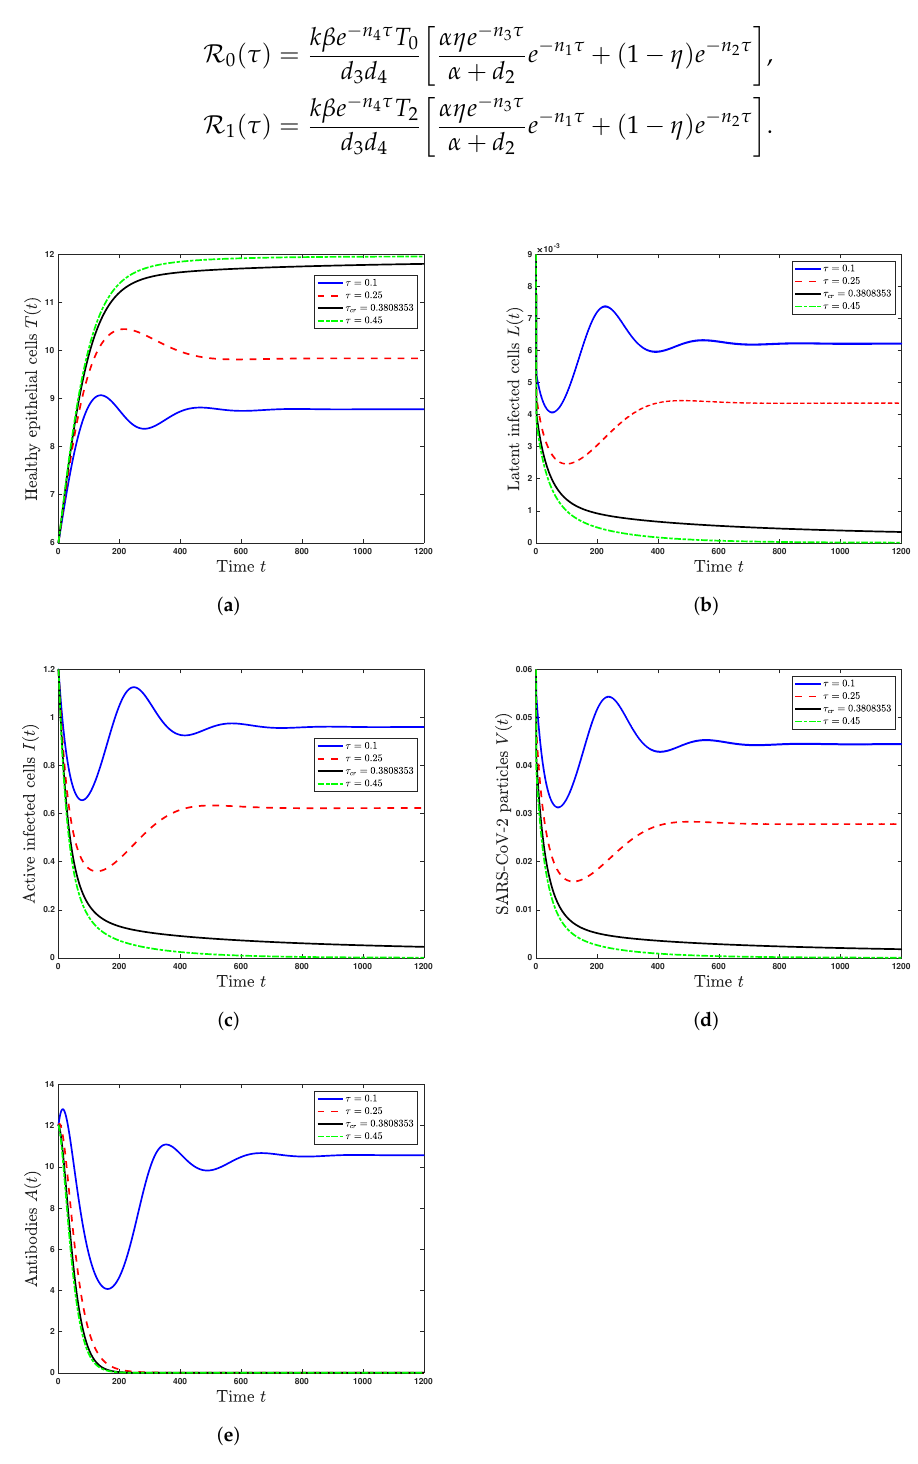
Figure 4. Solutions of system (19)–(23) under the influence of the time delay τ . ( a ) Healthy epithelial cells; ( b ) latent infected cells; ( c ) active infected cells; ( d ) SARS-CoV-2 particles; ( e )